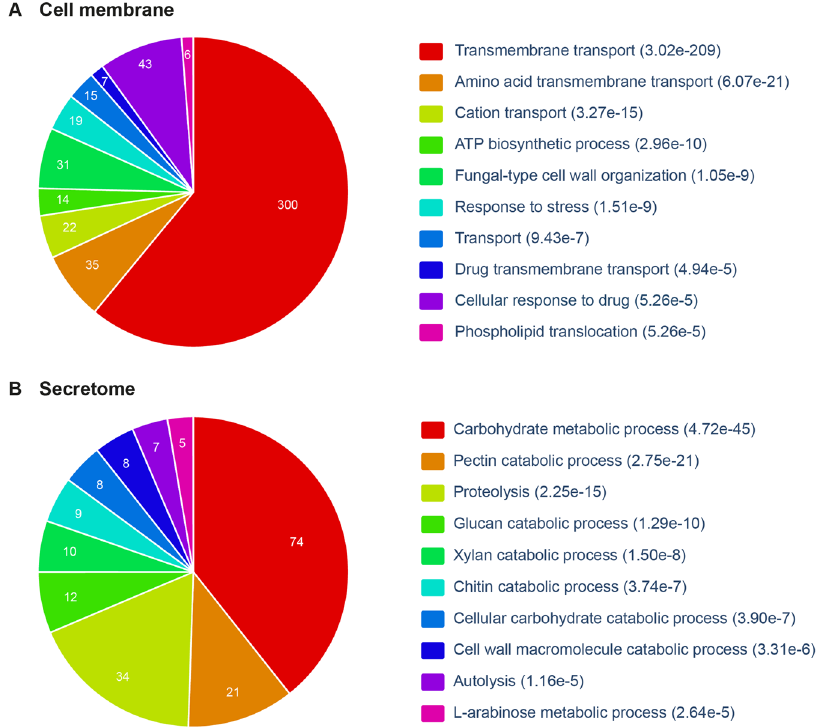
Figure 3. Gene ontology (GO) enrichment analysis for ( A ) cell membrane proteins and ( B ) secreted extracellular proteins in A. fumigatus Af293. In each case, the top 10 significantly enriched biological processes are shown along with p-value computed using Benjamini-Hochberg procedure. The GO enrichment analysis was performed using FungiFun2 147 webserver